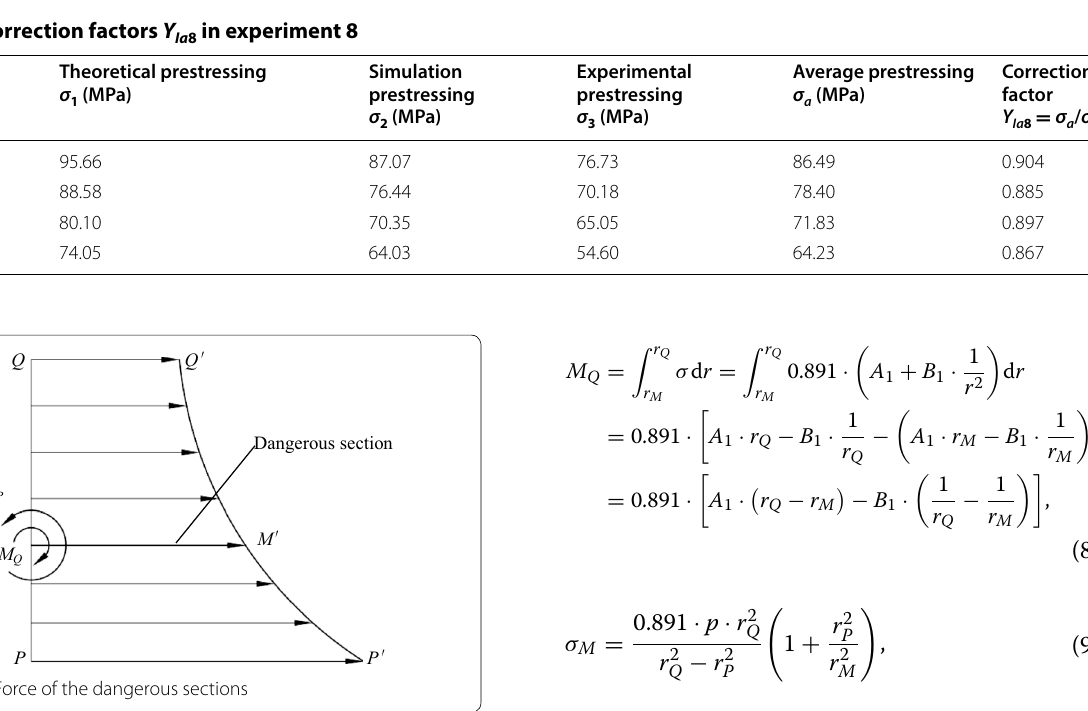
where r Q r i (radius of interface), r P r r (reference = = S radius of ring gear), r M = 2tan (γ − α) , the tooth thickness of the dangerous section is S [27, 28], the normal loading angle is γ , and the pressure angle is α .